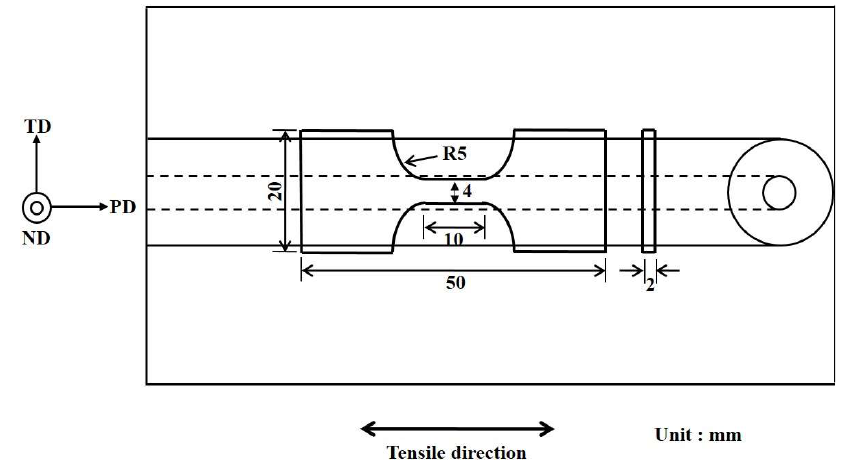
Figure 2. Schematic illustration of the tensile specimen (FSP). (processing direction: PD; normal direction: ND; transverse direction: TD).